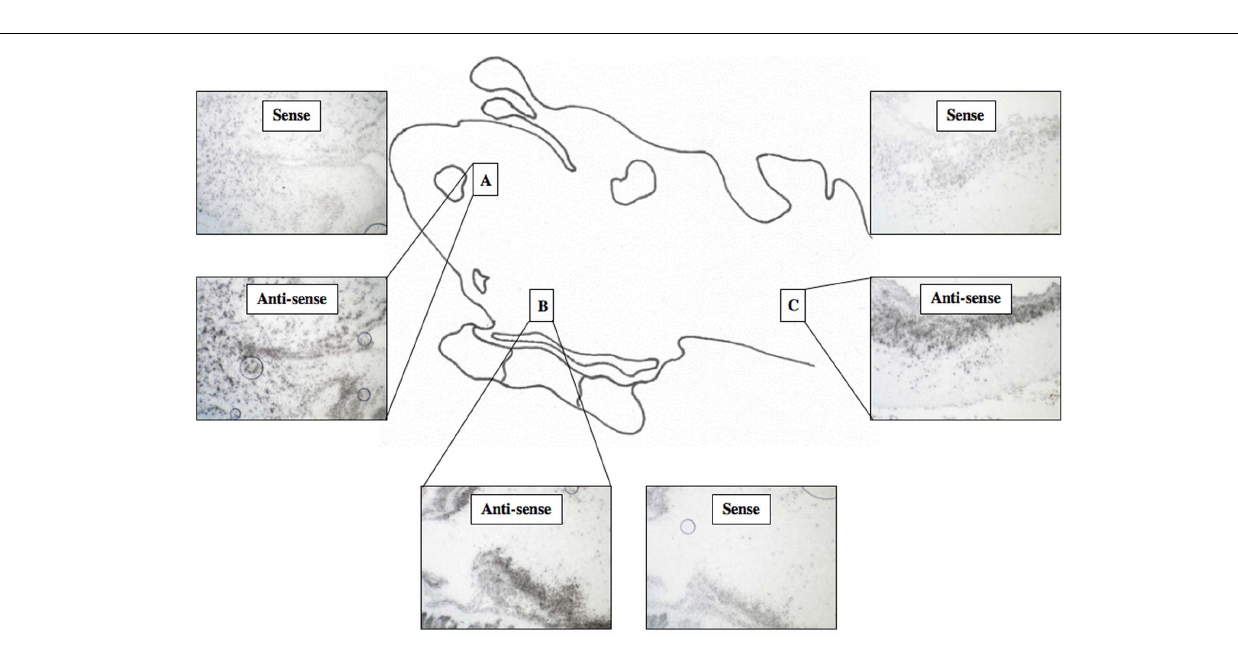
possibility of interaction between E2 and GnRH, and is consistent with previous evidence that E2 feedback is occurring indirectly or directly via GnRH neurons (Sower,